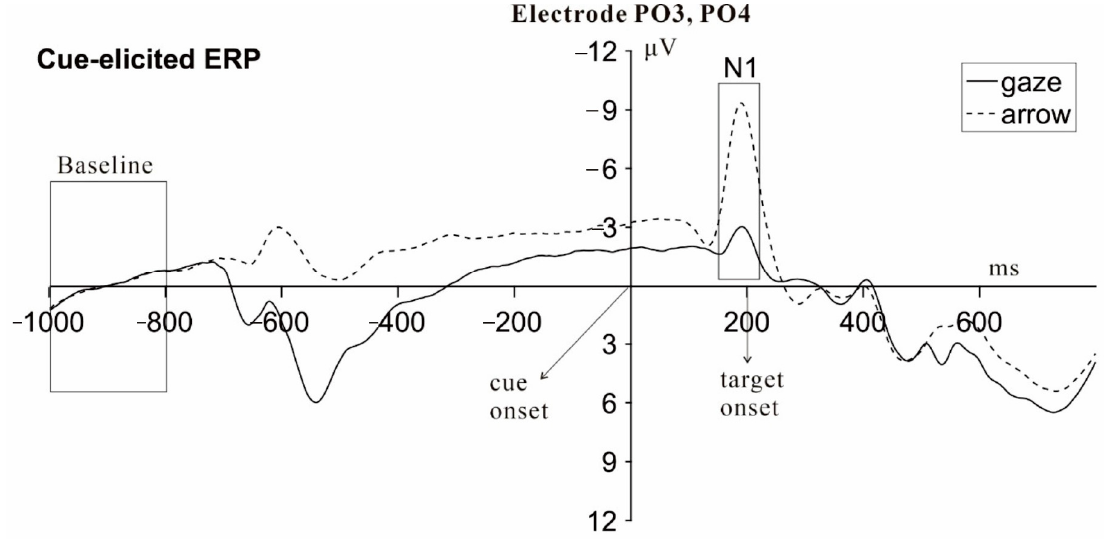
Figure 4. Grand-average cue-synchronized ERP waveforms for gaze and arrow cue conditions. Highlighted (right box) are the N1 components (averaged across electrodes PO3, PO4). Time zero on the x -axis corresponds to cue onset. The baseline was chosen at − 1000 to − 800 ms before the cue, corresponding to the 200 ms before the onsets of the horizontal line and face with direct gaze.